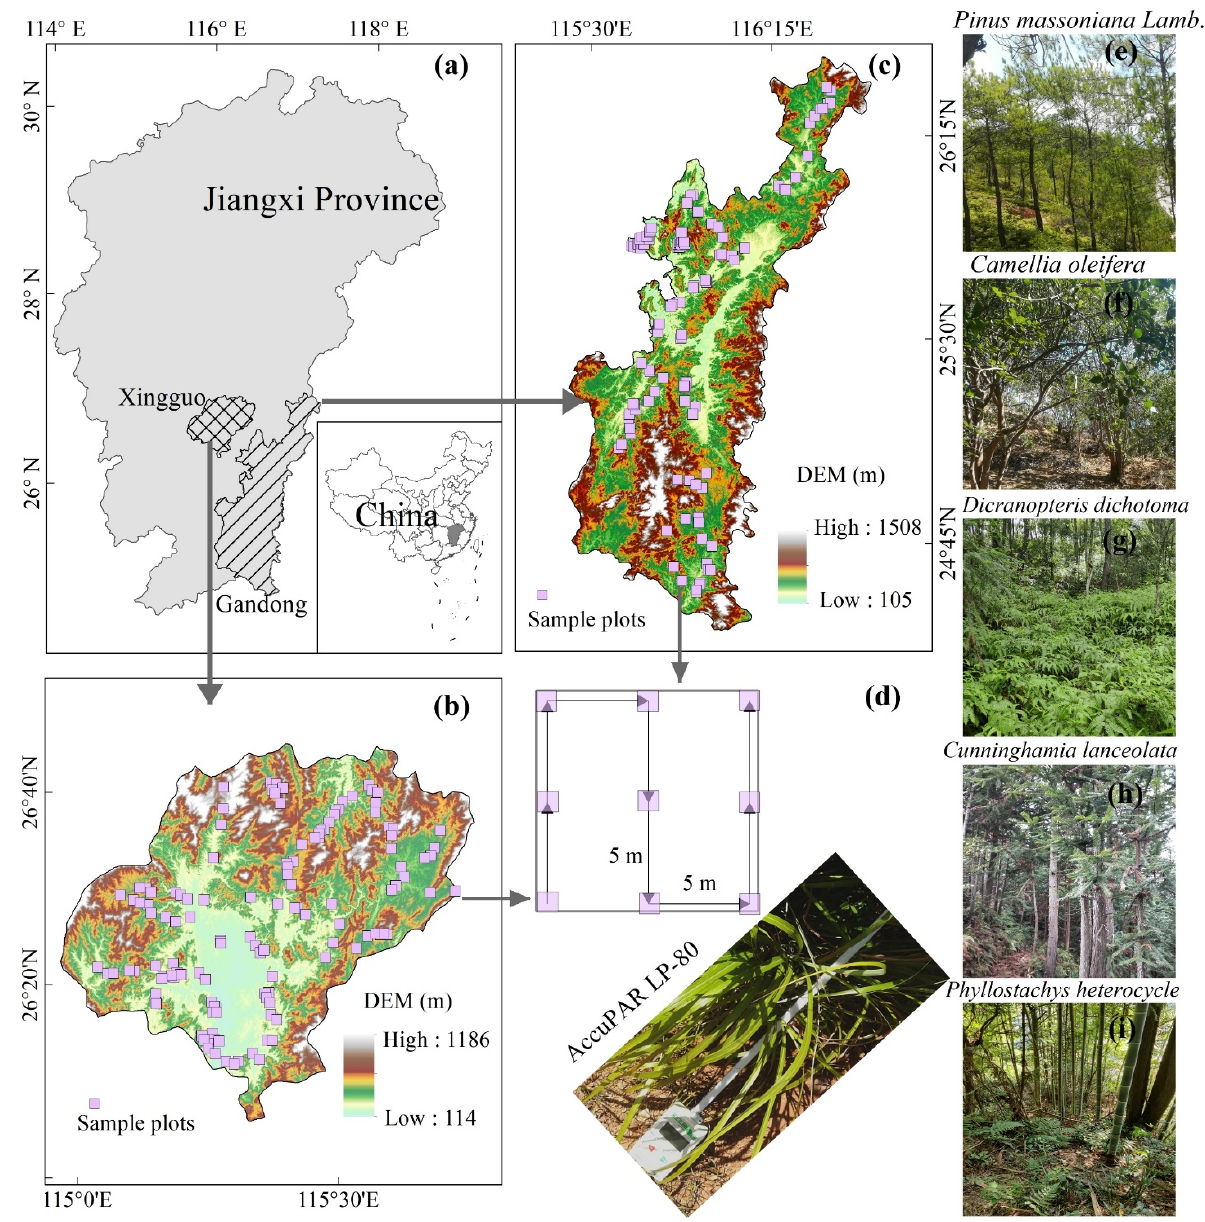
Figure 1. ( a ) Locations of the study areas; ( b ) the sampling points are displayed in the DEM images in Gandong; ( c ) the sampling sites are displayed in the DEM images in Xingguo; ( d ) field sampling strategy for measurements of LAI below canopy; and ( e – i ) figures of the dominant plant species.